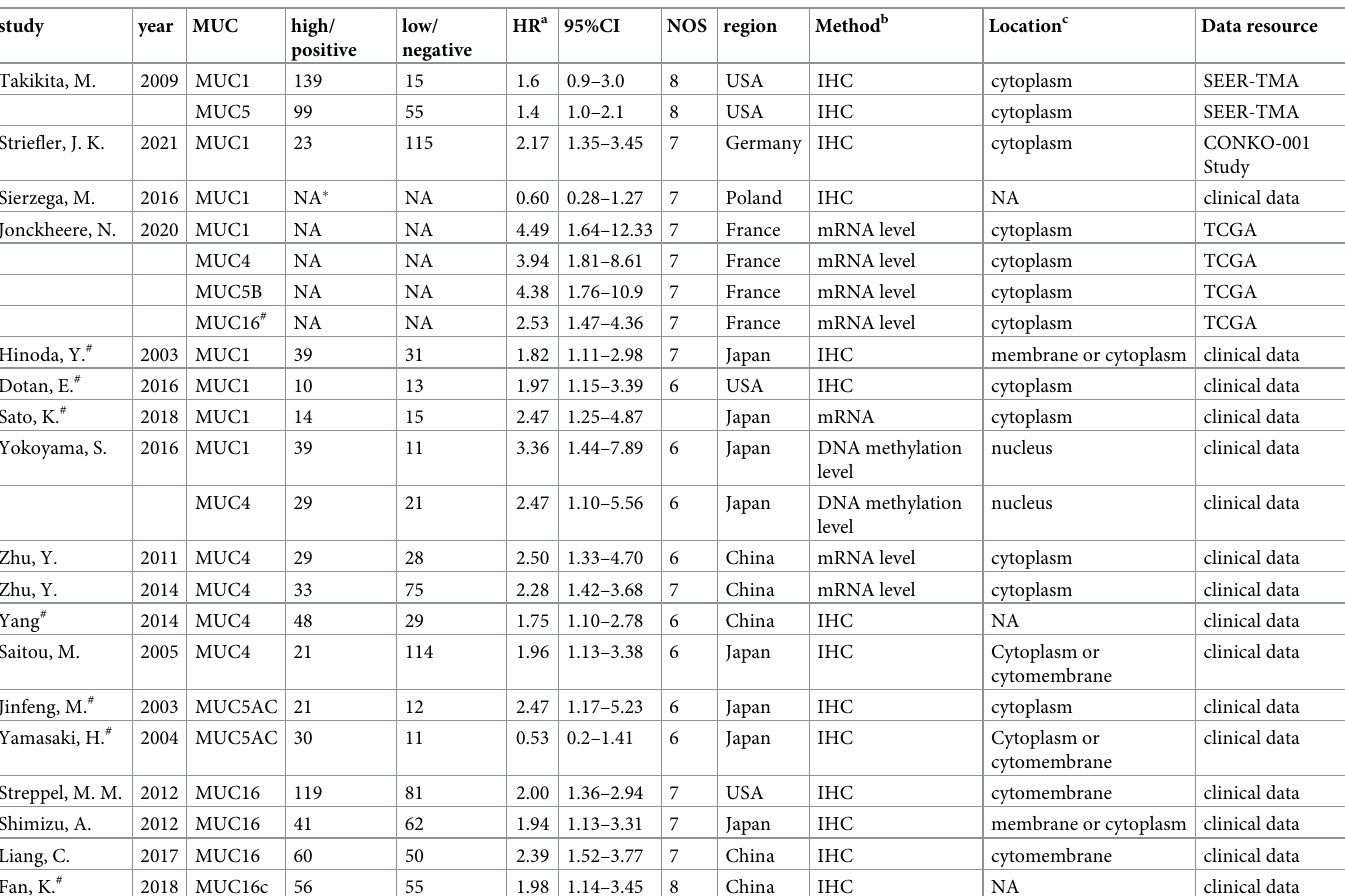
Table 1. Characteristics of included